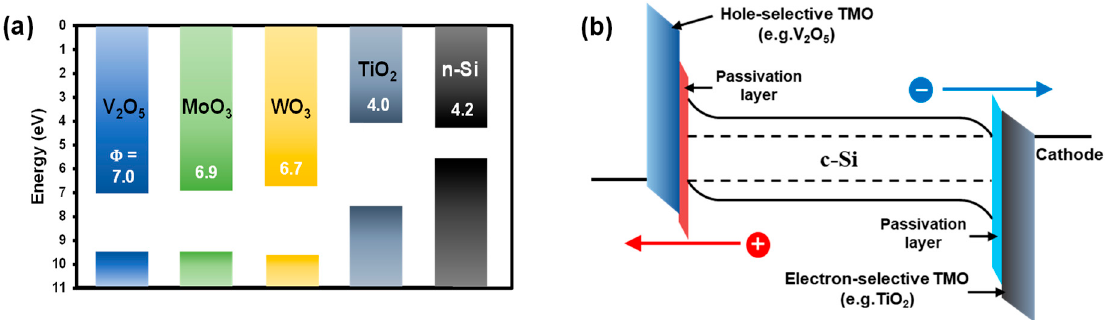
Figure 1. ( a ) Reported work functions ( Φ ) for TMOs (V 2 O 5 , MoO 3 , WO 3 , and TiO 2 ) and ( b ) energy band diagram with electron- and hole-selective contacts for c-Si/TMO HSCs.